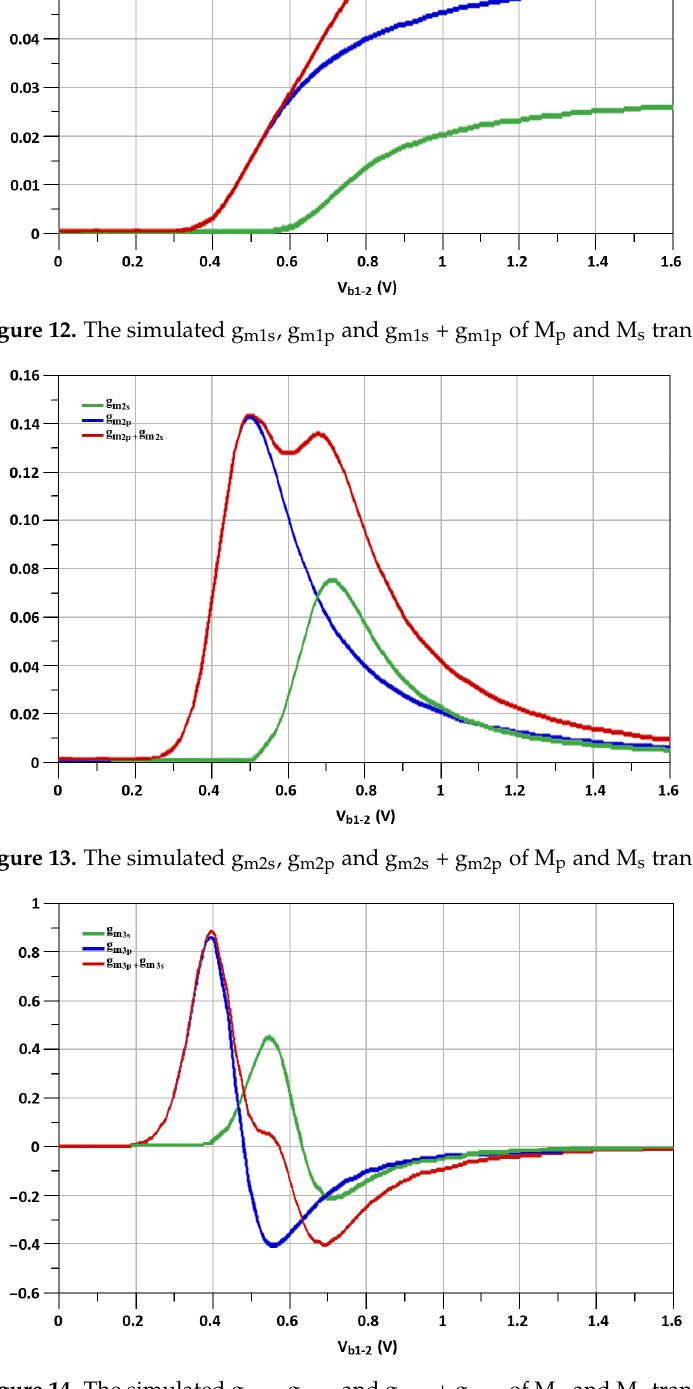
Figure 14. The simulated g m3s , g m3p and g m3s + g m3p of M p and M s